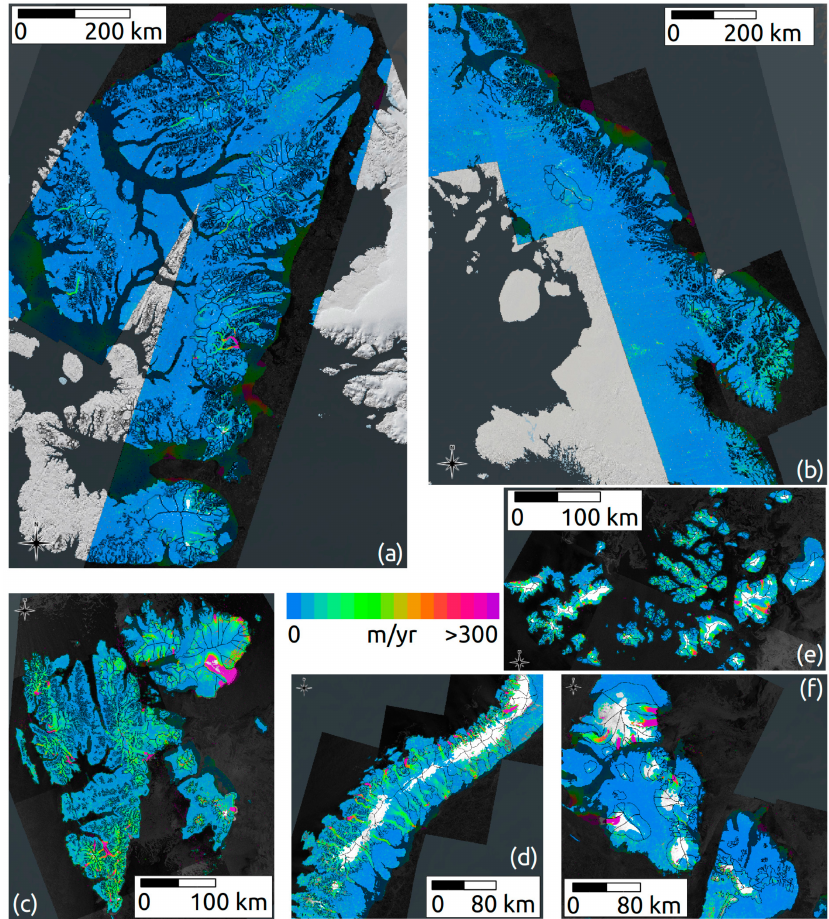
Figure 3. Ice velocity maps from Sentinel-1 SAR winter data of ( a ) 2015 over the Canadian Arctic North; ( b ) 2016 over the Canadian Arctic South; ( c ) 2015–2016 (average) over the Svalbard Archipelago; ( d ) 2017 over Novaya Zemlya; ( e ) 2016 over Franz-Josef Land; and ( f ) 2016–2017 over Severnaya